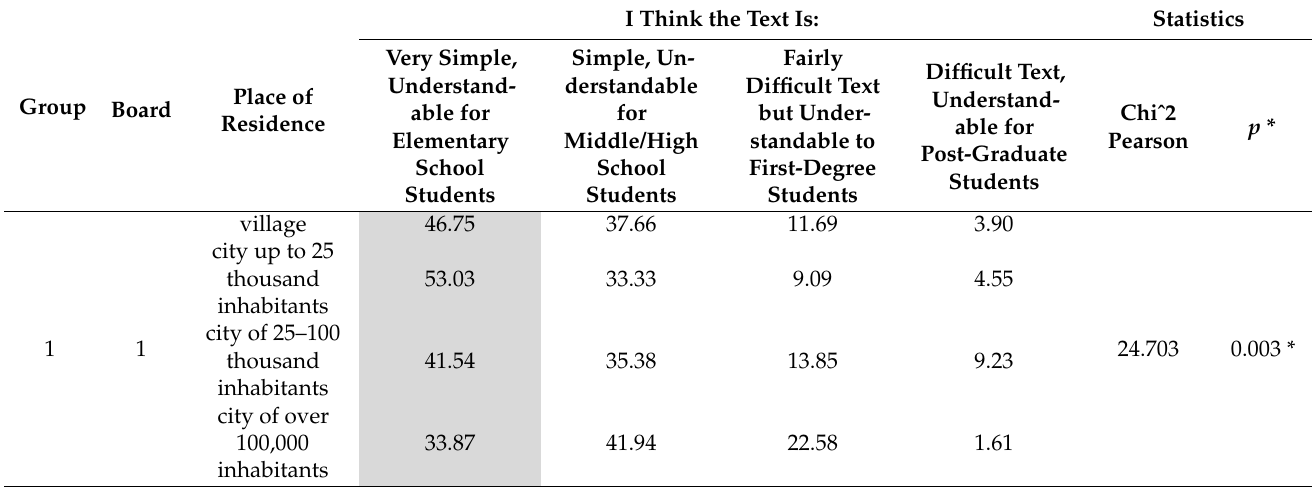
Table 9. Differences in ratings of text accessibility on educational boards by place of